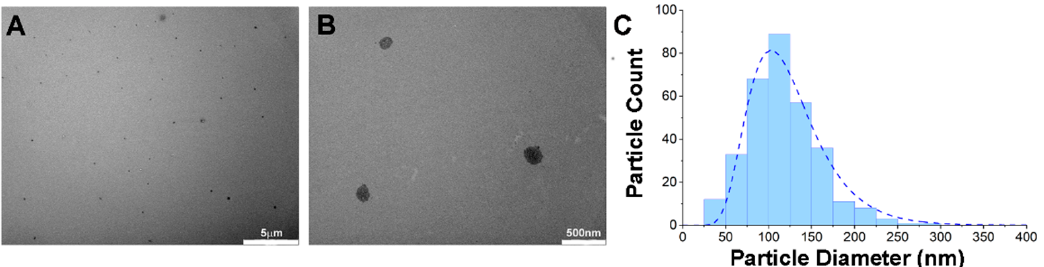
Figure 1. Physical characterizations of PTX-Ce6@ker nanoformulation. ( A , B ) Representative Transmission electron microscopy (TEM) micrographs of PTX-Ce6@ker nanoparticles performed at a final concentration of 0.1 mg/mL (5 µm and 500 nm scale bar, respectively). ( C ) The graph shows the diameter distribution of keratin-based nanoparticles determined by analysis of TEM images (n = 319).